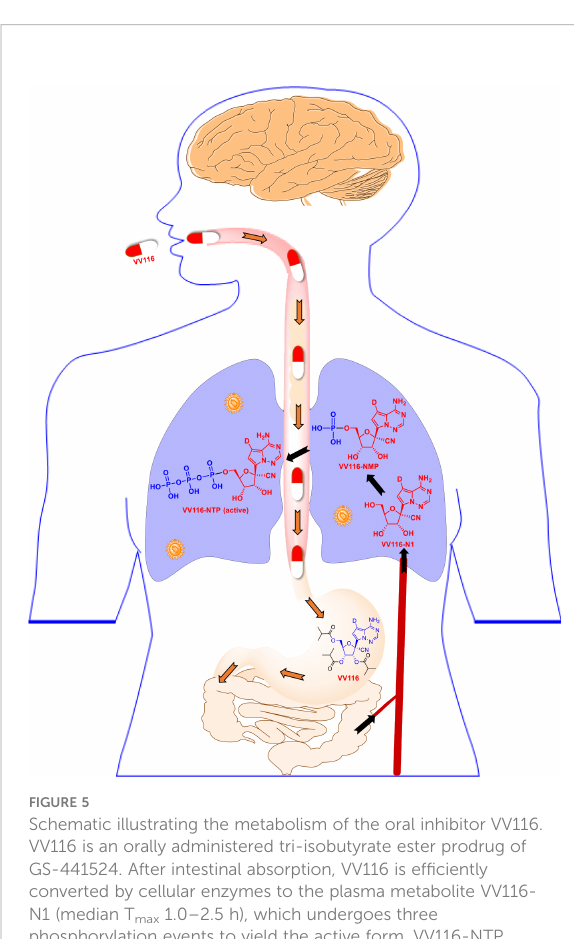
FIGURE 5 Schematic illustrating the metabolism of the oral inhibitor VV116. VV116 is an orally administered tri-isobutyrate ester prodrug of GS-441524. After intestinal absorption, VV116 is ef fi ciently converted by cellular enzymes to the plasma metabolite VV116- N1 (median T max 1.0 – 2.5 h), which undergoes three phosphorylation events to yield the active form,